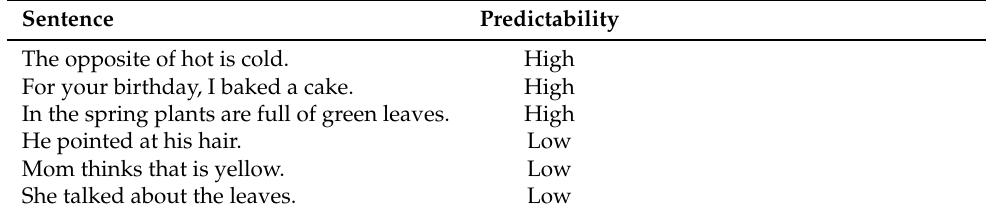
Table 1. Example high and low predictability sentence